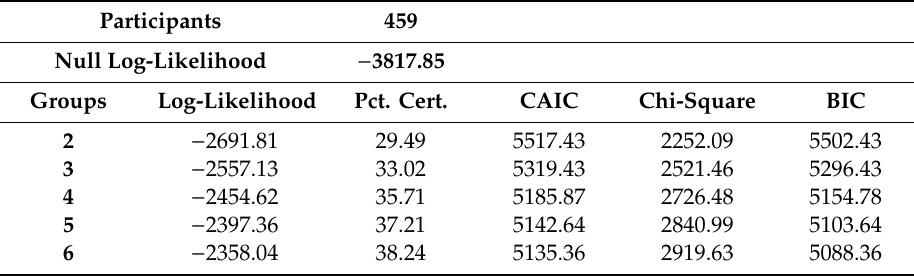
Table 4. Criteria for selecting the optimal number of